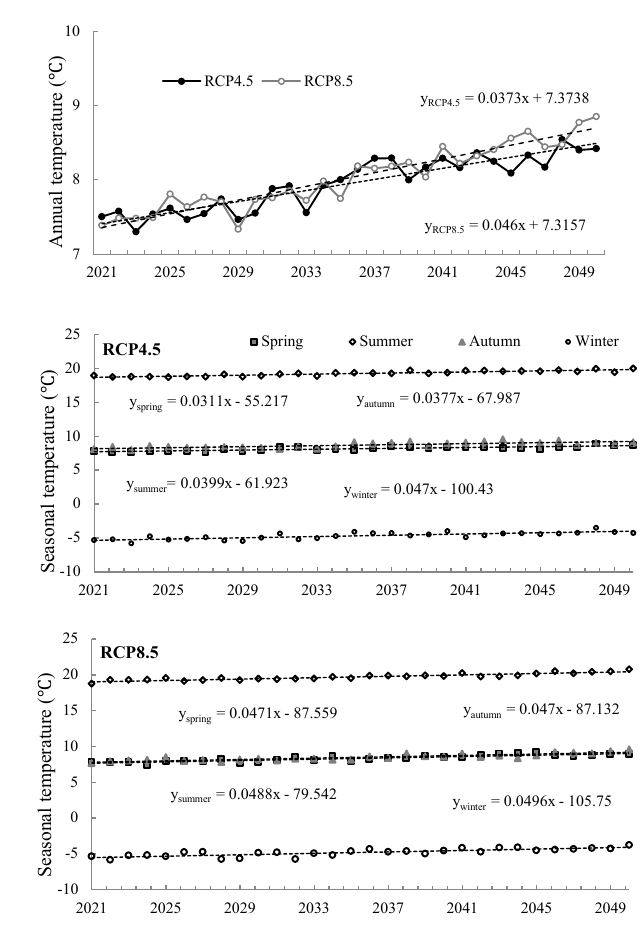
Figure 5. The time series of annual and seasonal temperature for RCP4.5 and RCP8.5 from 2021 to 2050 in